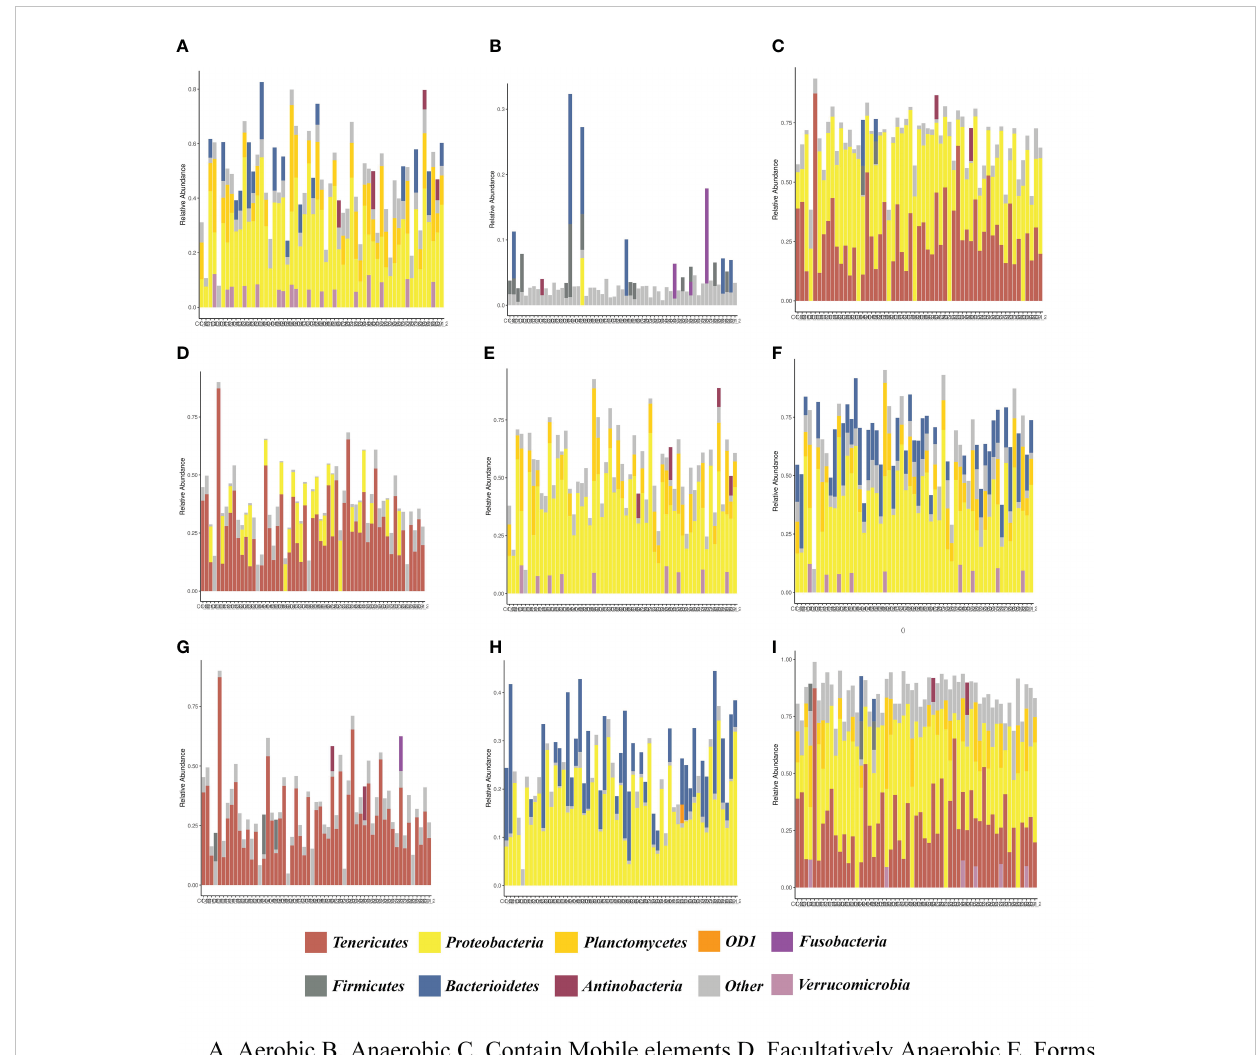
FIGURE 7 The relative abundances of species in phylum level with different phenotypes in different groups. (A) Aerobic, (B) Anaerobic, (C) Contain Mobile elements, (D) Facultatively Anaerobic, (E) Forms Bio fi lms, (F) Gram negative, (G) Gram positive, (H) Potentially Pathogenic, (I) Stress